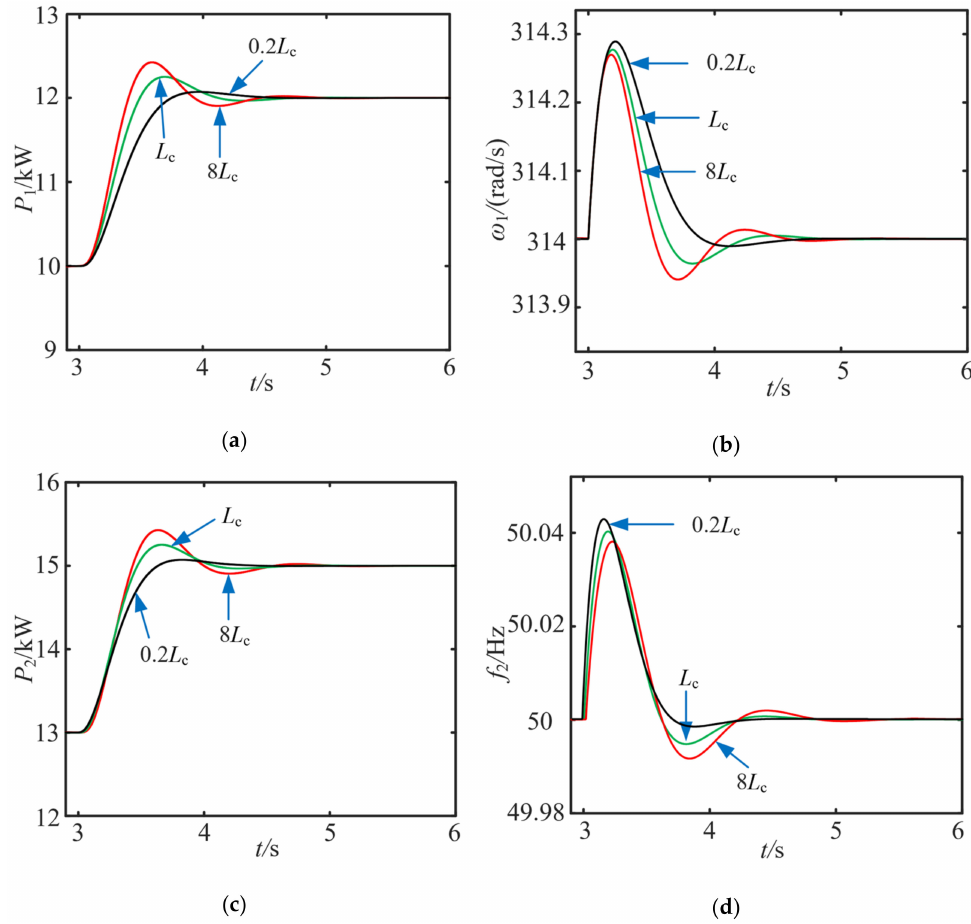
Figure 17. Simulation waveforms with different line inductances: ( a ) active power of VSG1; ( b ) virtual angular frequency of VSG1; ( c ) active power of VSG2; ( d ) frequency of